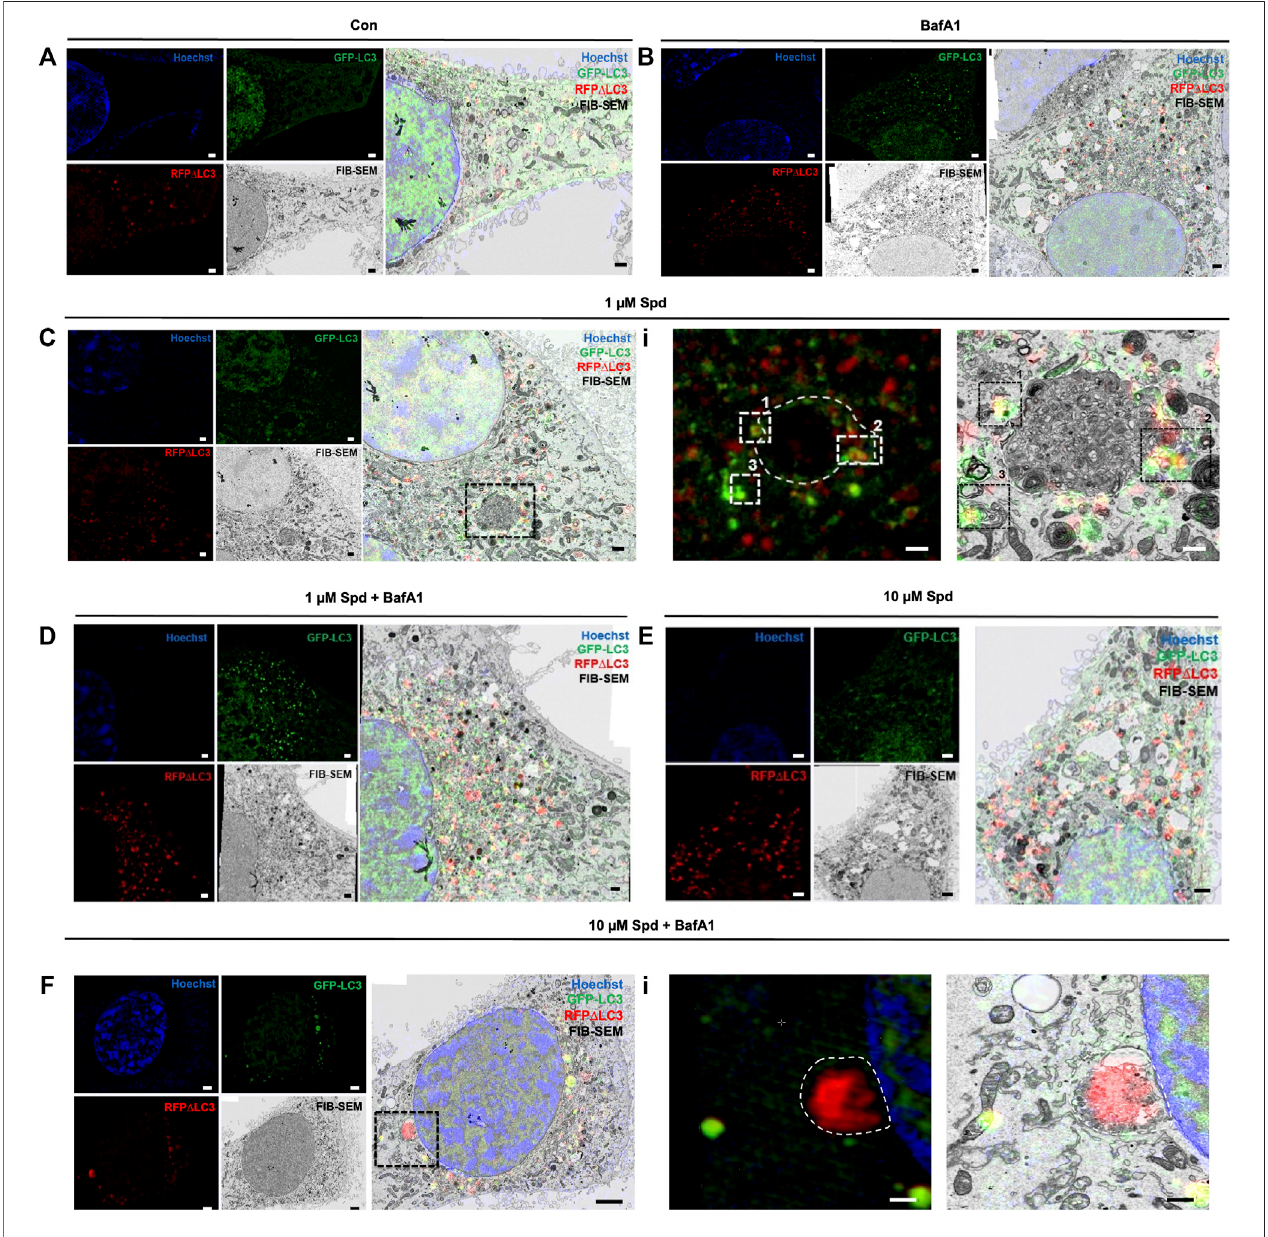
FIGURE 4 | Spermidine induces autophagy. (A – F) Three colour micrograph of SR-SIM, FIB-SEM and overlay of SR-SIM and FIB-SEM showing the accumulation of GFP-LC3 and RFP-LC3 Δ G positive structures following treatments. (C , F) complex structures of high electron density. (Ci) region of interest showing GFP-LC3 and RFP-LC3 Δ G positive structures decorating conglomerate structure. ( Fi ) region of interest showing the localisation of RFP-LC3 Δ G positive structures inside the conglomerate structure as part of cytoplasmic cargo. Scale bar: 1 μ m.